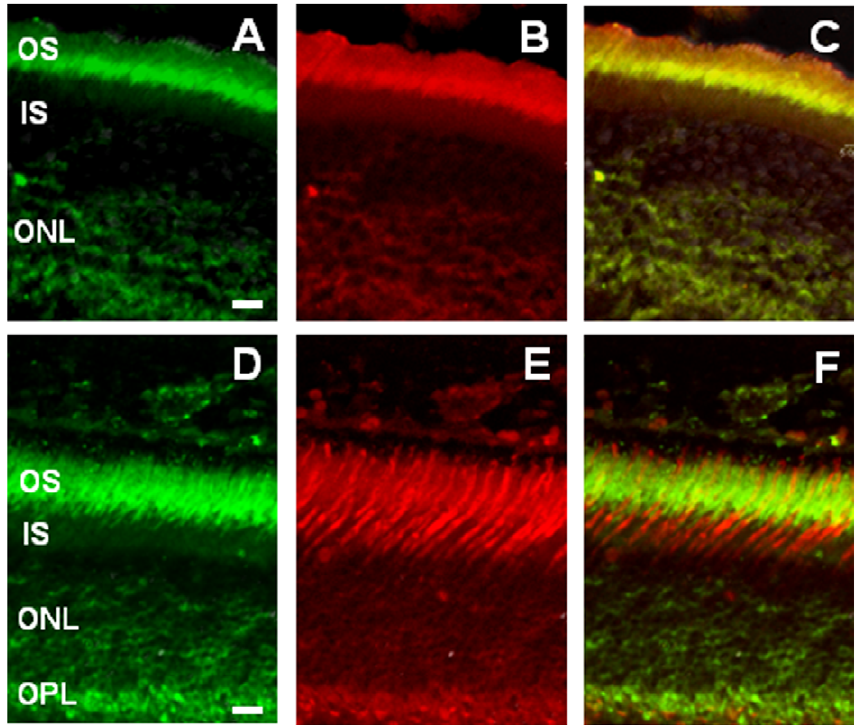
Figure 2. MT 1 receptor immunoreactivity in photoreceptor cells. MT 1 immunoreactivity was localized with rod outer-inner segments (A=MT 1 ; B=rhodopsin; C=merge) and to cones outer-inner segments (D=MT 1 ; E=peanut agglutinin; F=merge) and to a lesser extent, to the pedicles of the cones. The co-localization of MT1 receptor signal with rods or cones is evident in panels B and C, respectively, where the images have been merged. The bars at the bottom of the Figures represent 10 m m. Micrographs are representative of results obtained from at least three mice.